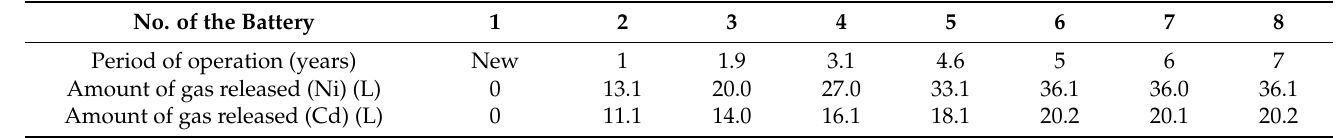
Table 2. Dependence of the amount of accumulated hydrogen in the electrodes on the service life of the KSX-40 batteries at 25 ◦ C 1